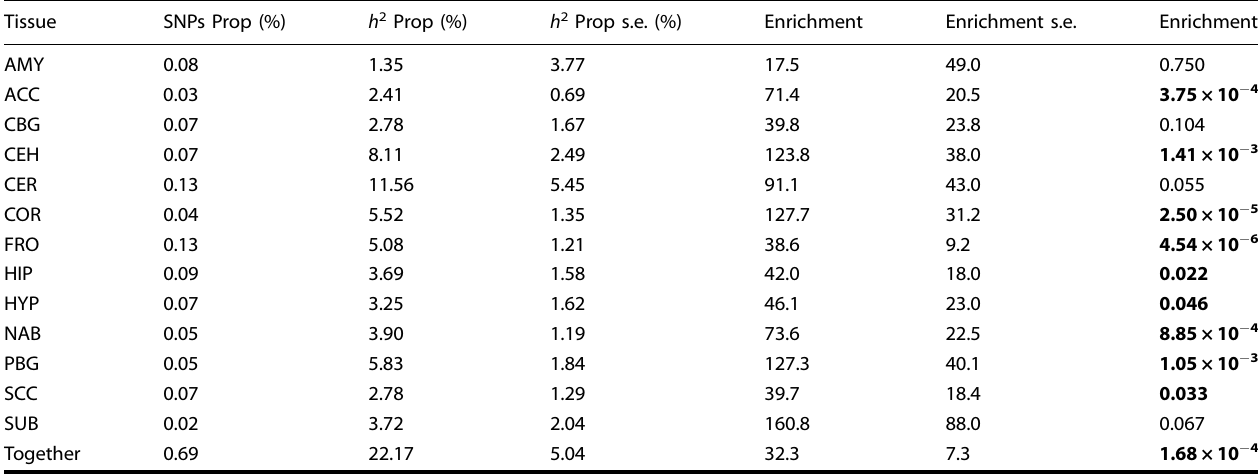
Table 1. Partitioned heritability of TWAS-identi fi ed genes. Tissue SNPs Prop